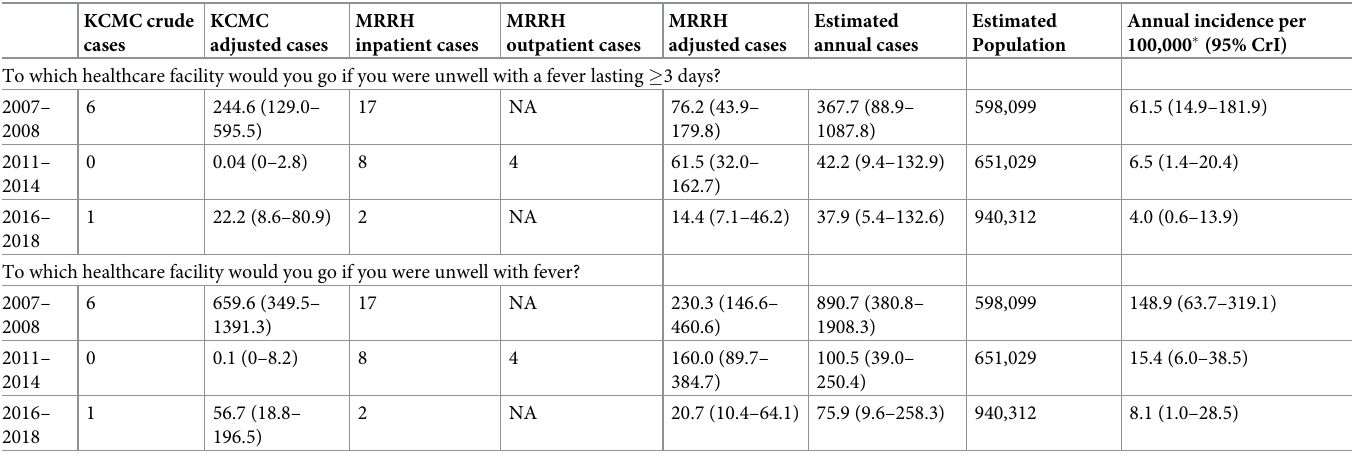
Table 5. Sensitivity analysis for overall typhoid incidence estimates, Kilimanjaro Region, Tanzania,